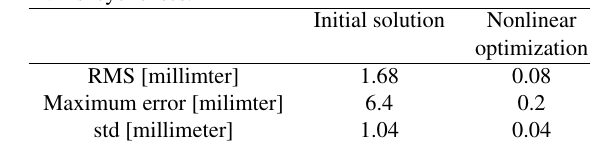
Table 1: The point-based back-projection error (19) from the ex- periment with Point Grey’s Firefly camera equipped with Fujinon YV fisheye lenses.